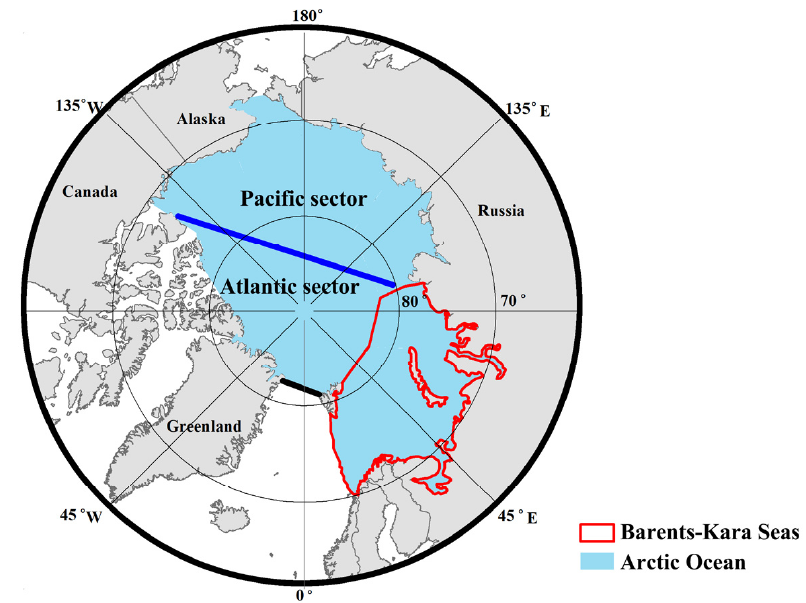
Figure 1. The Arctic Ocean. The red lines are the boundaries of the Barents–Kara Seas. The blue line (2826 km) shows the fluxgate by which the sea ice area is exchanged between the Pacific and Atlantic sectors. The black line (491 km) shows the fluxgate of the Fram Strait.